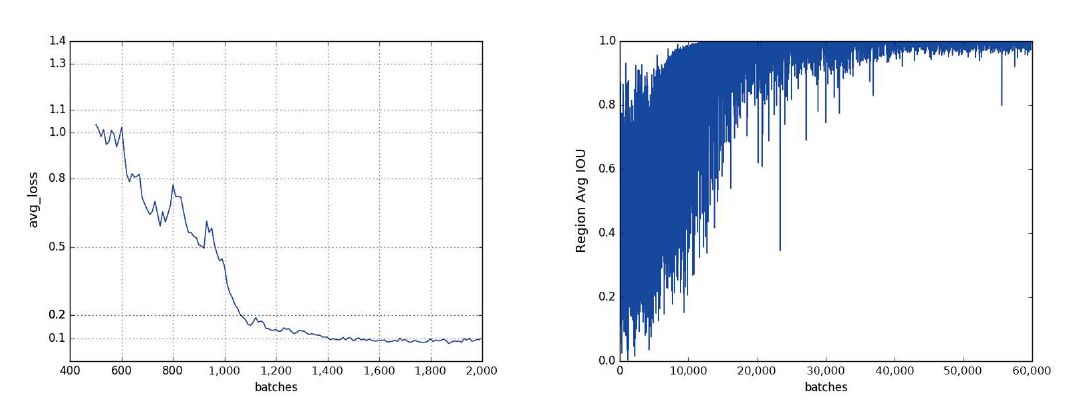
Figure 17. Loss and IoU curves of